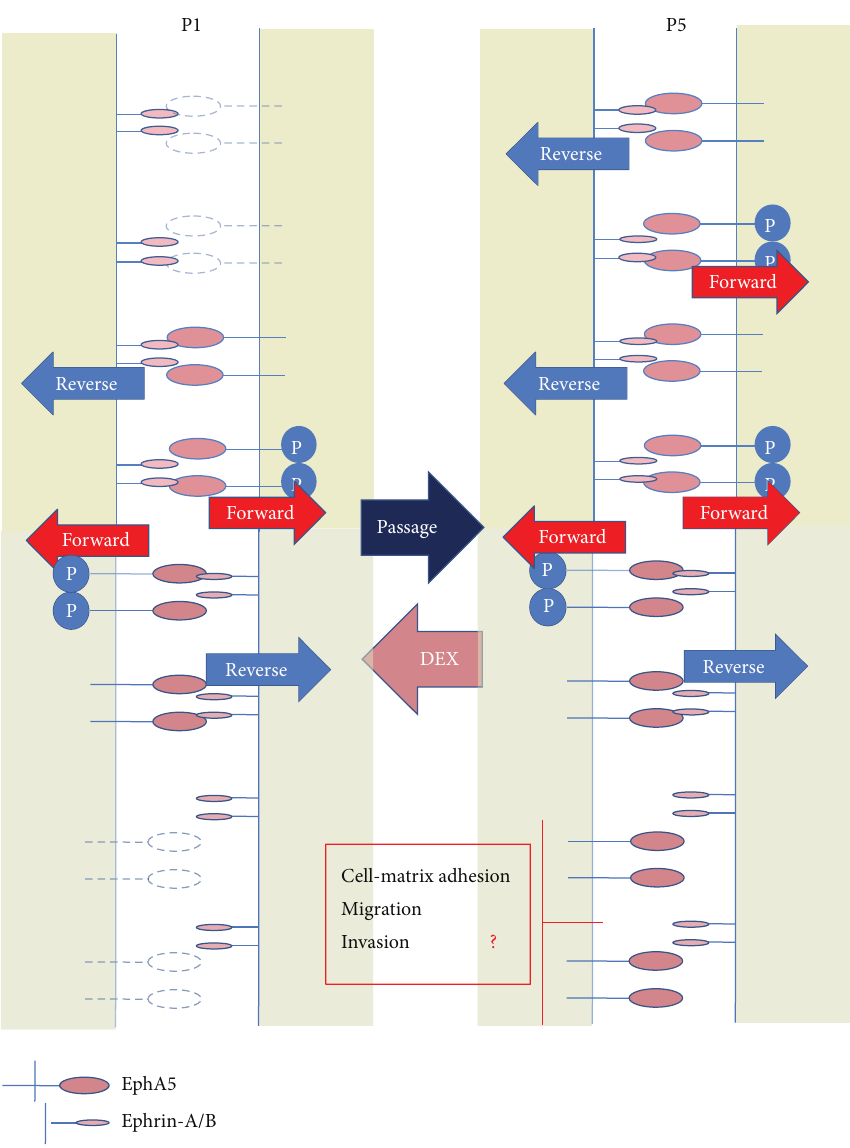
Figure 5: Proposed mechanisms by which EphA5 inhibits hBMSC osteogenesis. Coexpression of EphA5 and ephrins regulates hBMSC osteogenesis. Repeating passaging upregulates EphA5 but not ephrins, which results in an excess of nonligated EphA5. An imbalance between receptor and ligand expression may compromise other Eph ligand-dependent differentiation processes and promote ligand-independent suppression in